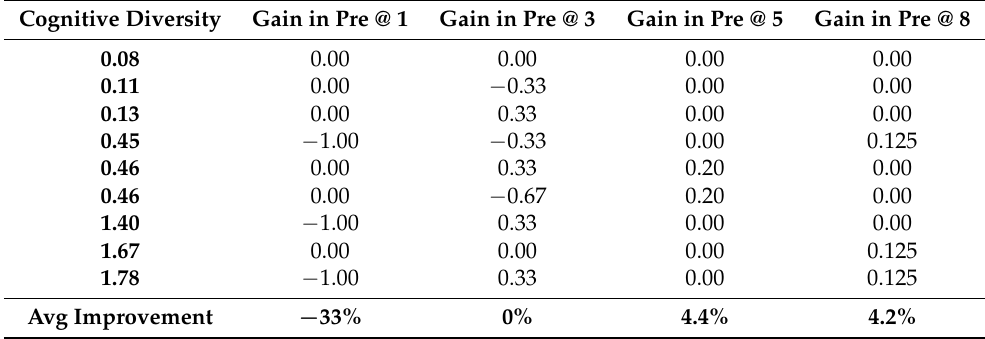
Table 9. Difference between precision results of Model RC ( A , B ) and the best of Models A or B for all test